Question: Write a single sentence explaining what this figure depicts.
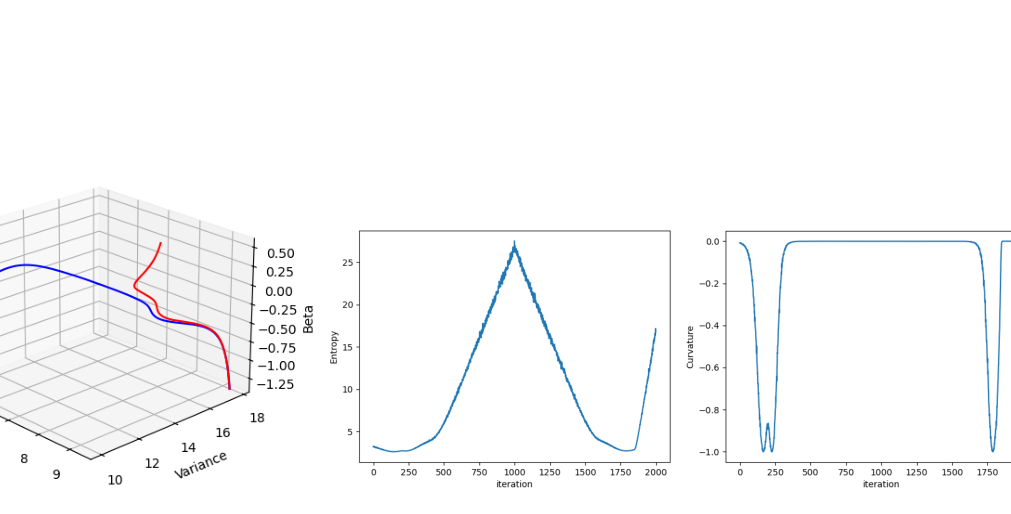
Answer: Geodesic curves, entropy and curvature evolution in the Gaussian random fields manifold obtained by the proposed iterative MCMC based fourth-order Runge-Kutta algorithm and its time reverse simulations (sixth row in Table 2). The blue curve denotes the orignal geodesic and the red curve denotes its time reversed version.